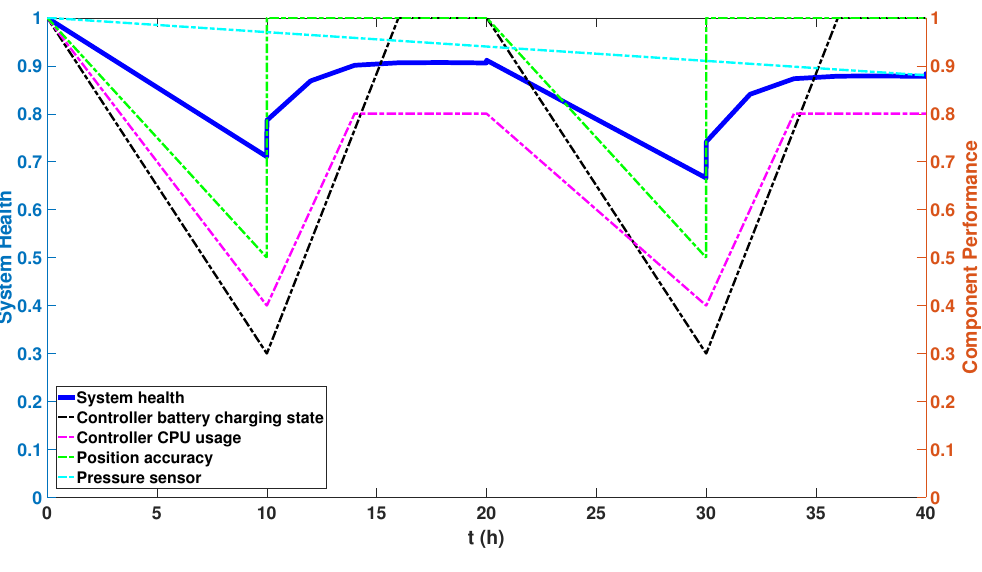
Figure 4. The simulation results of scenario case 1.